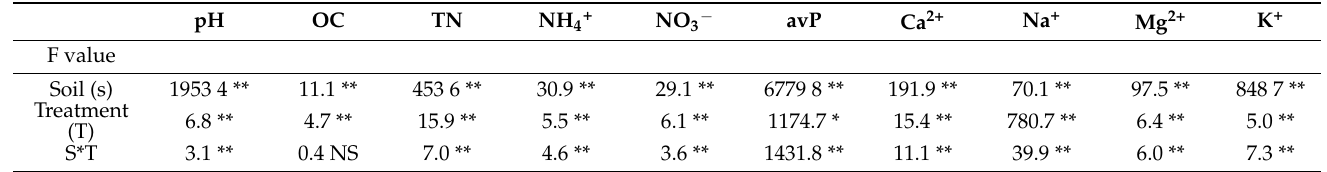
Table 3. Analysis of variance for the different soil chemical properties.